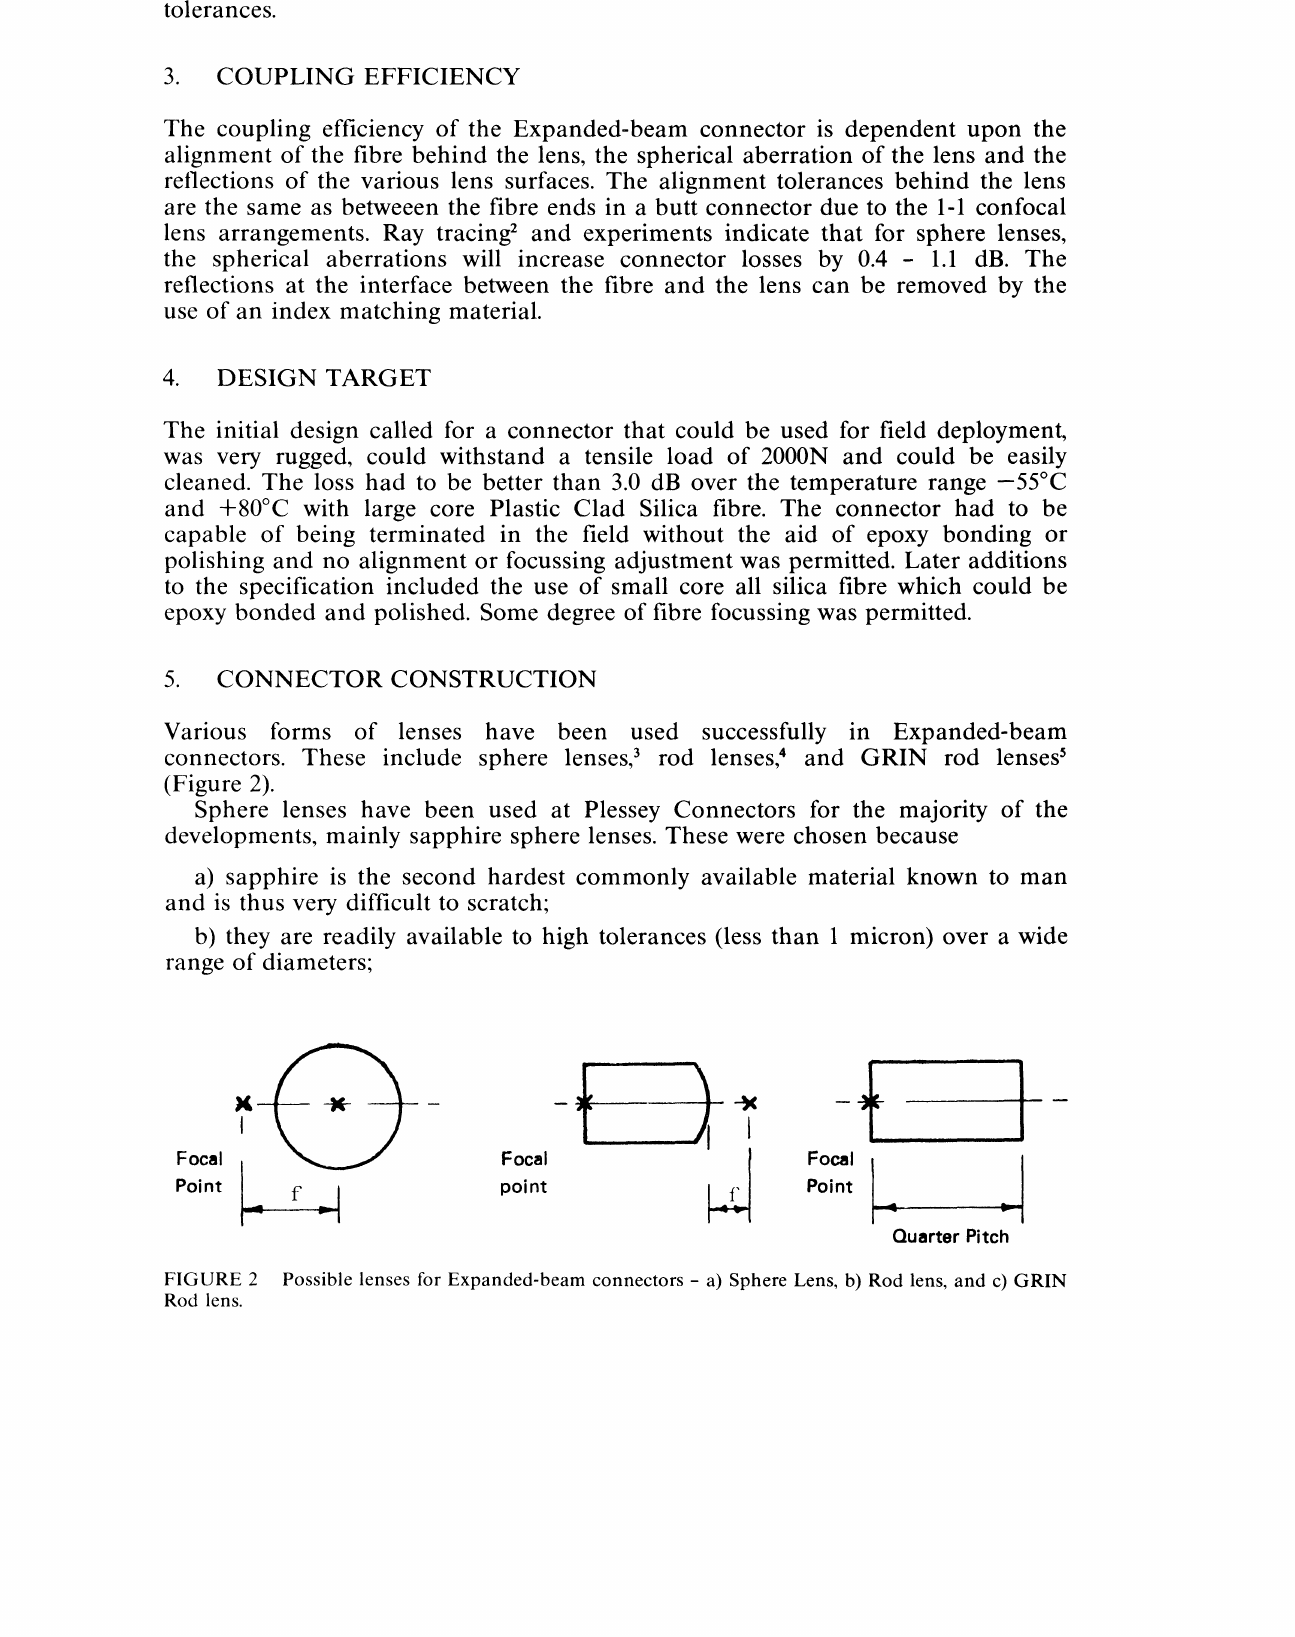
Possible lenses for Expanded-beam connectors a) Sphere Lens, b) Rod lens, and c) GRIN Rod